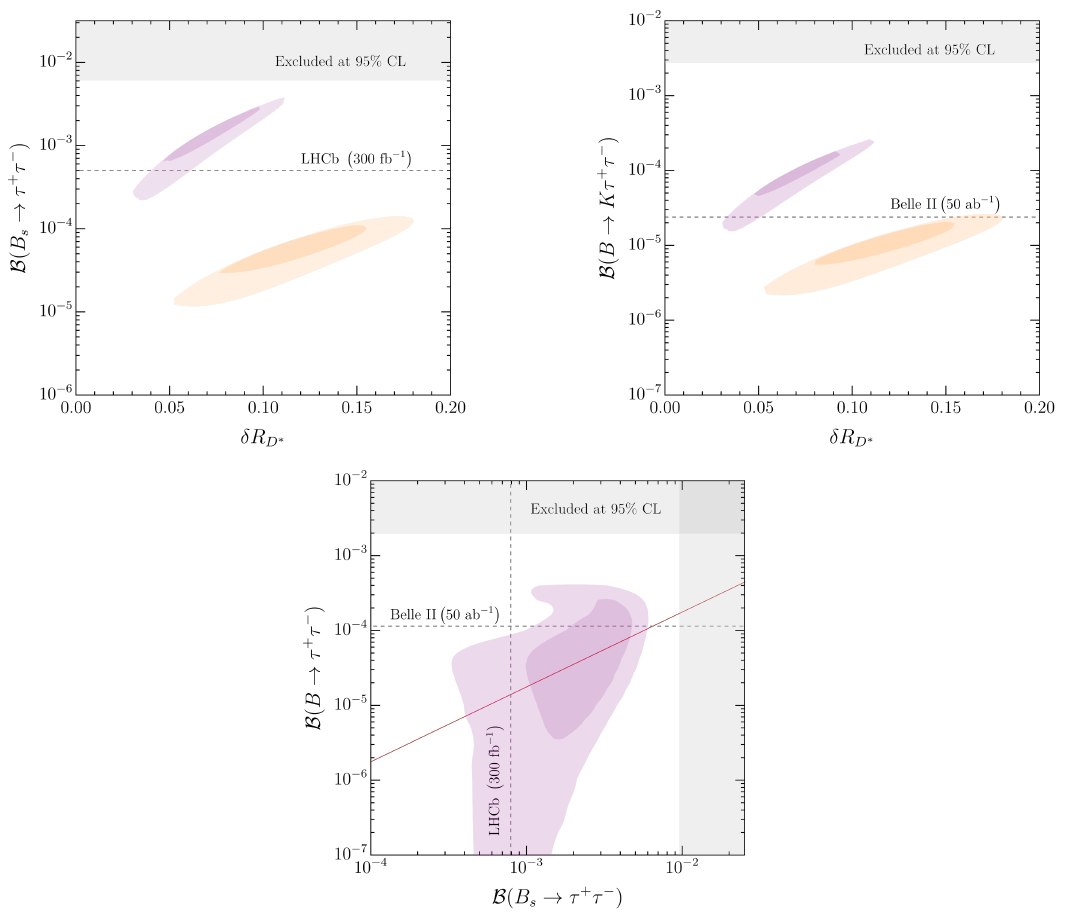
Figure 10 . Preferred 1 σ and 2 σ regions for di-tau final states resulting from the low-energy fit in the U simplified model for β bτ = 0 (orange) and β bτ = − 1 (purple). The gray bands show the 1 R R 95% CL experimental exclusion limits. Future projections (rescaled to 95% CL) are denoted by dashed lines. The red line in the lower plot shows the expected relation between B ( B and B ( B → τ + τ − ) for β dτ = V ∗ (minimally broken U(2) 5 /β sτ /V ∗ ts L L td